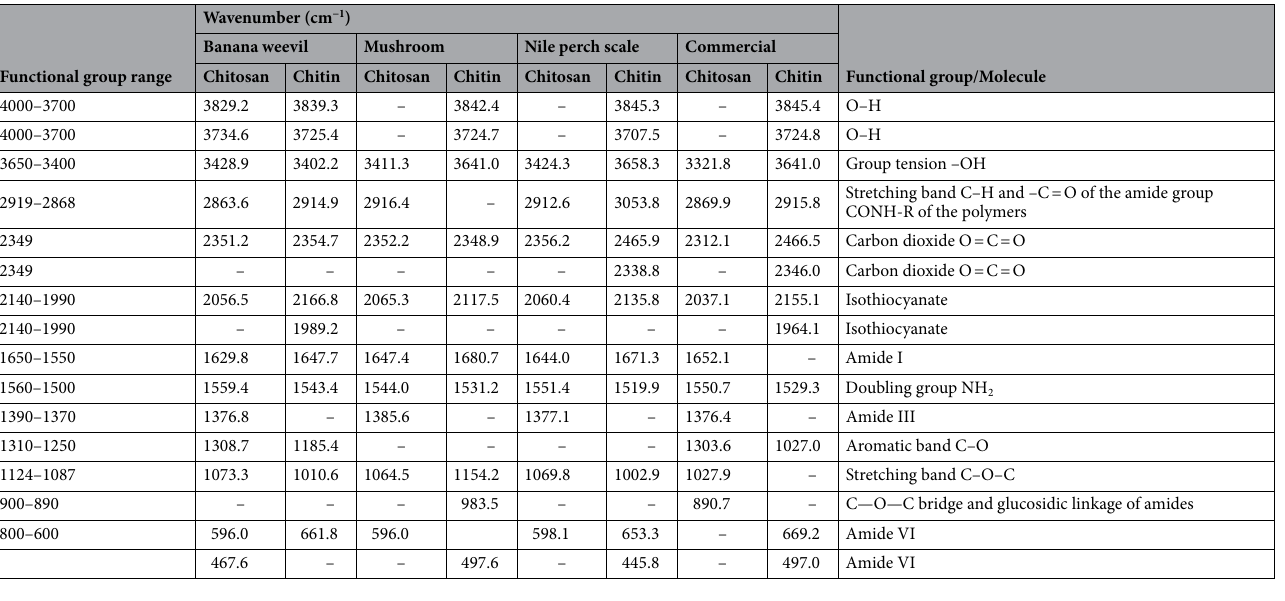
Table 3. Comparison of FTIR characteristic bands for chitin and chitosan isolated from locally available materials and commercial chitosan band